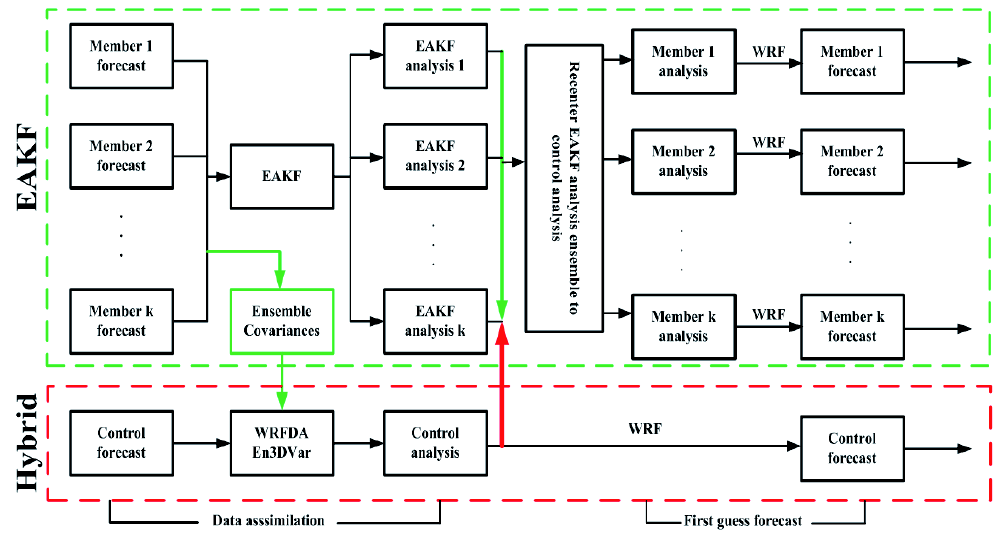
Figure 1. Implementation and framework of a hybrid ensemble adjustment Kalman filter—three-dimensional ensemble—variational (EAKF-En3DVar) radar data assimilation system, with coupling between EAKF (green dashed box) and En3DVar (red dashed box) hybrid control analysis. The thick red arrow indicates the feedback of En3DVar hybrid control analysis to the EAKF, when the En3DVar hybrid control analysis is used to the replace the ensemble mean of the EAKF analyses.